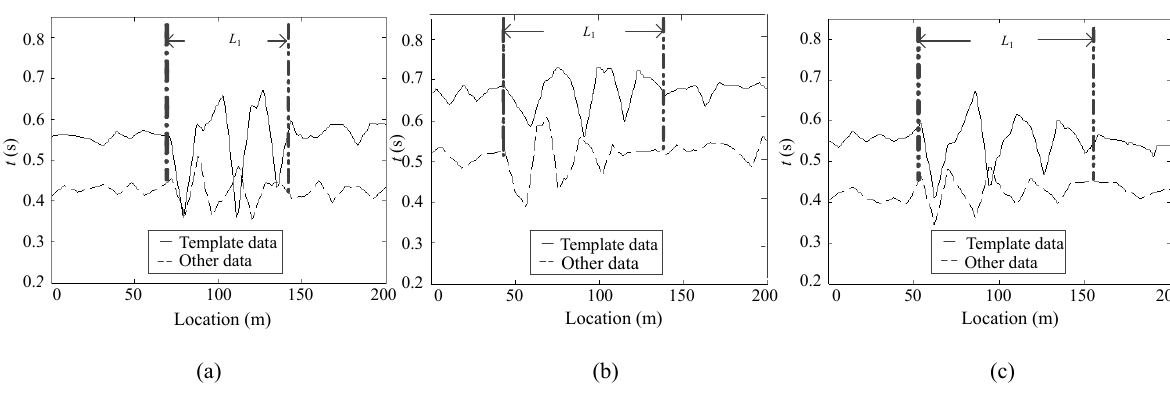
Fig. 5 Scale of corrected signal: (a) picking, (b) shoveling, and (c)